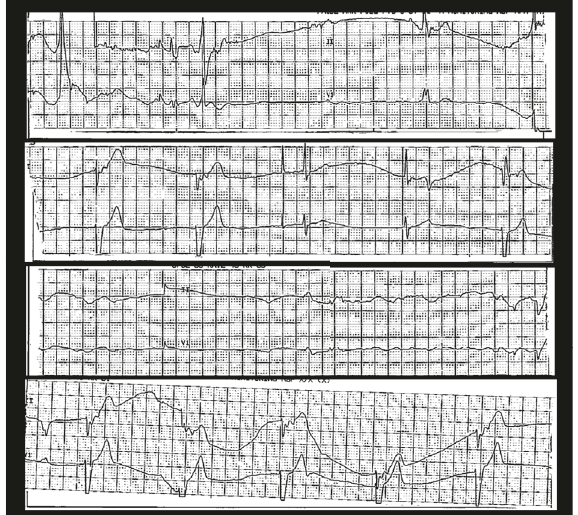
Figure 1: Telemetry strips showing bradycardia and sinus arrest coincidental with the patient’s syncope.